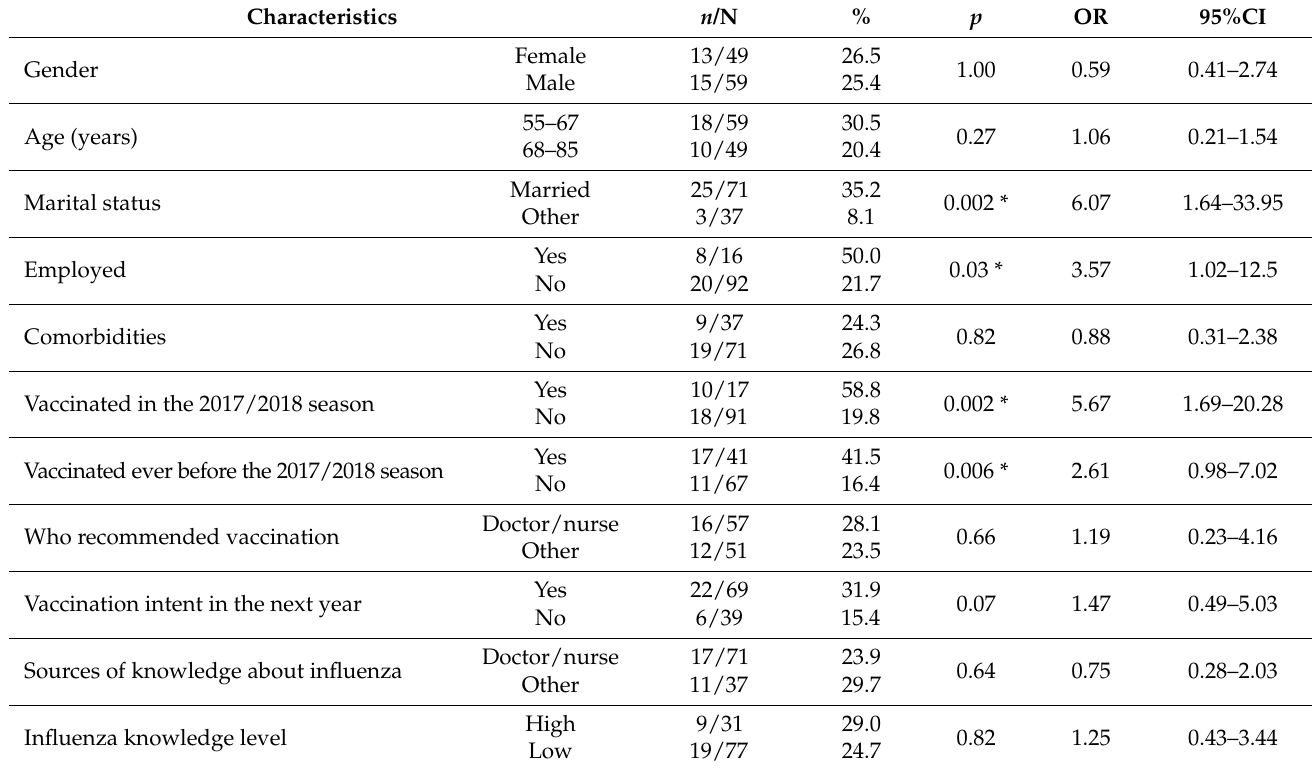
Table 1. Factors affecting the continuation of vaccination in the epidemic season.2019/2020, Gryfino, Poland; ( n =